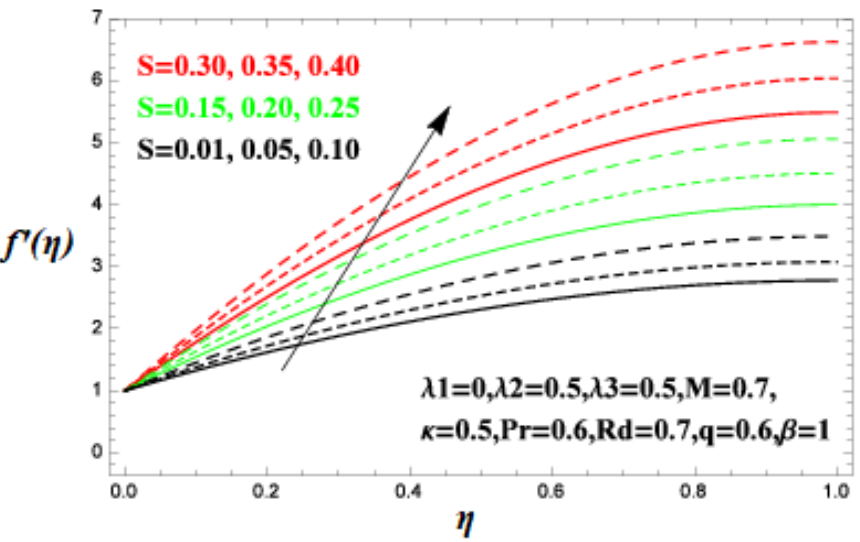
Figure 8. Fluctuations in f ( η ) for several numbers of S .